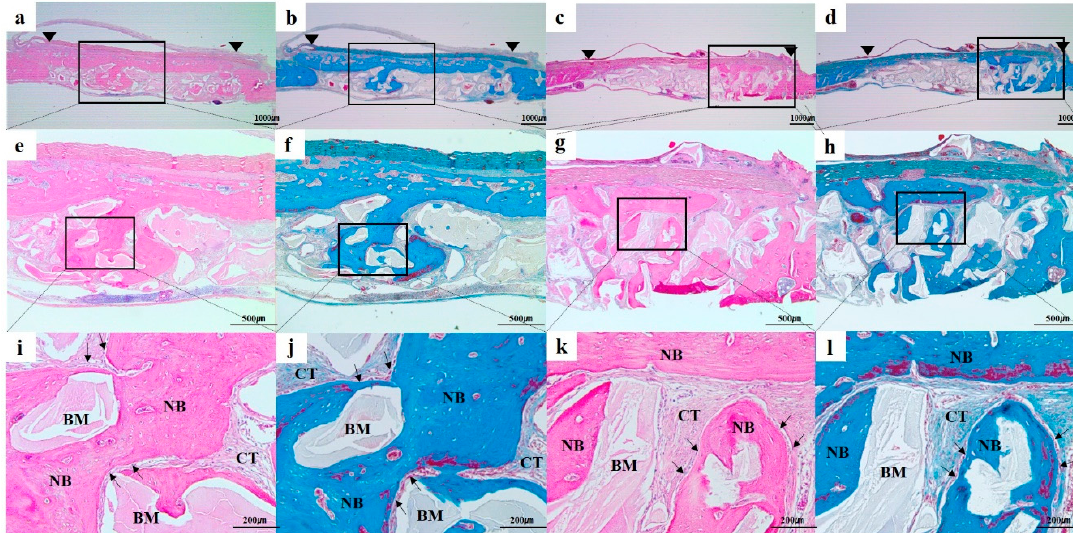
Figure 11. Histologic sections of ( a,b,e,f,i,j ) Bio-Oss and ( c,d,g,h,k,l ) Bone-XP groups at 4 weeks post-surgery. ( a,c,e,g,i,k ) haematoxylin and eosin (H&E) stained slides; ( b,d,f,h,j,l ) Masson’s trichrome (MT) stained slides; Arrowhead: original defect edge; Arrow: lines of osteoblasts NB: newly generated bone; CT: connective tissue; BM: residual bone grafts. [Original magnification: ( a – d ) ×12.5, ( e – h ) ×40, ( i – l ) ×100].